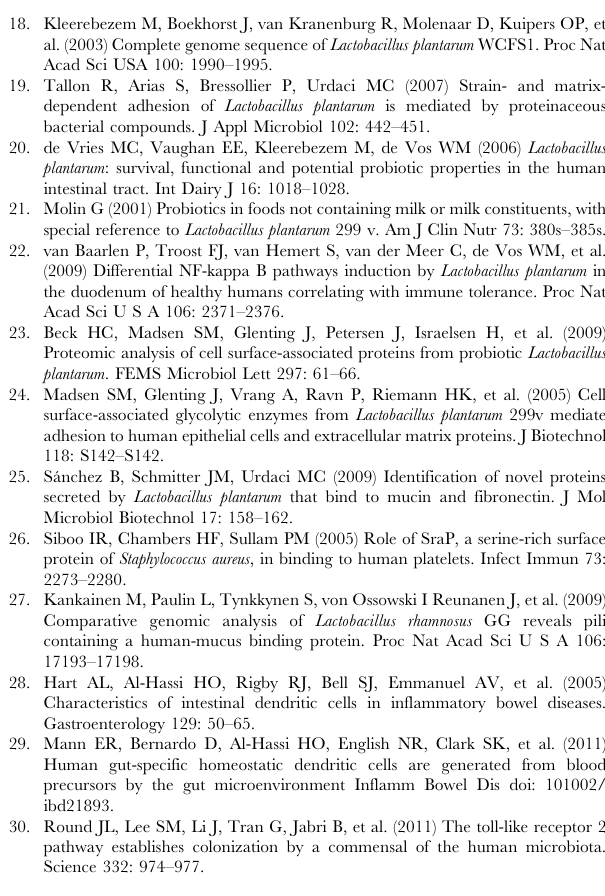
Figure S1 Slide 1: Theoretical cleavage sites of the intestinal proteases chymotrypsin, pepsin and trypsin were predicted at the ExPASy proteomic server, using the peptide cutter application (http://expasy.org/tools/peptidecutter/). The ST domain, where no predicted cleavage sites are predicted, is highlighted with the black arrow. Table S1 Strains and primers used in the present work. * NaeI recognition sites are underlined, and sequence coding for the histidine tag double-underlined. Table S2 antibodies used for flow